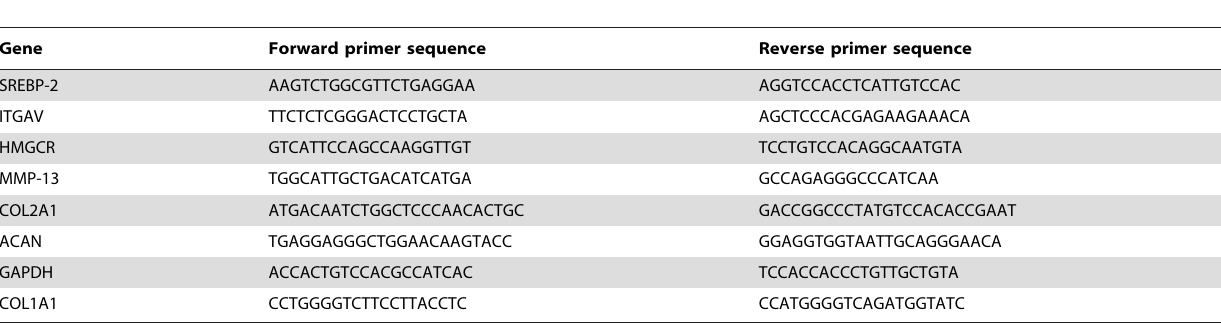
Table 3. Oligonucleotide primers used in real-time PCR